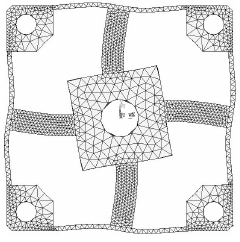
Figure 11. Mechanical model of an elastic body under M